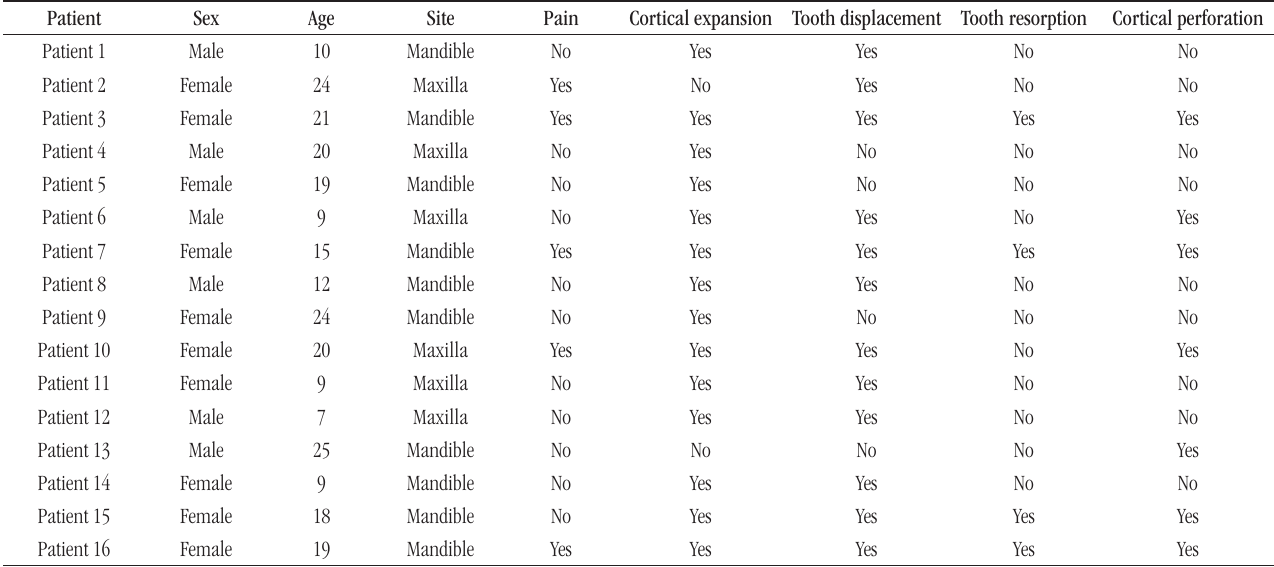
taBLE 1 − Criteria adopted in CGCG classification, according to biological behavior